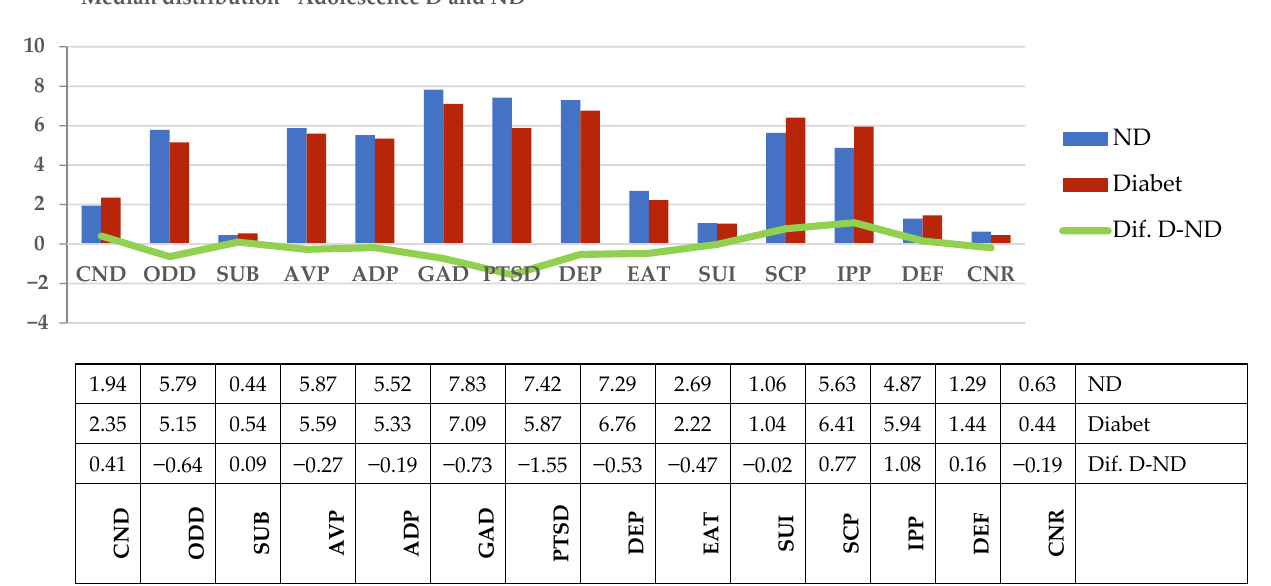
Figure 1. Median distribution of ASP–SF subscales in adolescents with IDD (D) and control group (ND). Legend: Conduct Disorder (CND), Oppositional Defiant Disorder (ODD), Substance Abuse Disorder (SUB), Anger/Violence Proneness (AVP), Academic Problems (ADP), Generalized Anxiety Disorder (GAD), Post-Traumatic Stress Disorder (PTSD), Major Depression (DEP), Eating Disturbance (EAT), Suicide (SUI), Self-Concept (SCP), Interpersonal Problems (IPP), Defensiveness (DEF), and Consistency Response (CNR).